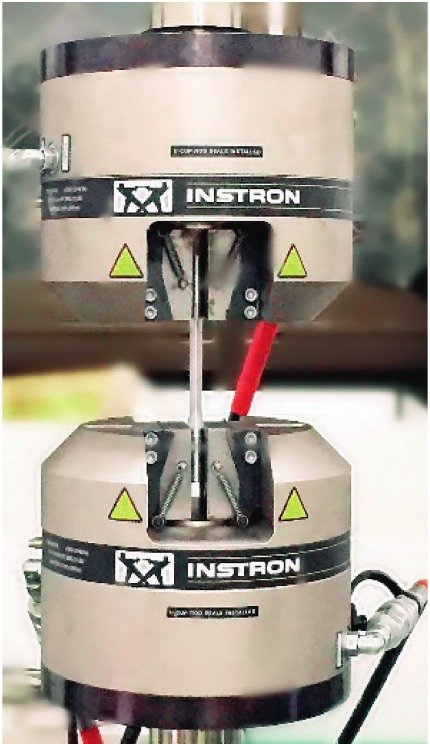
Figure 6: Fatigue testing setup.